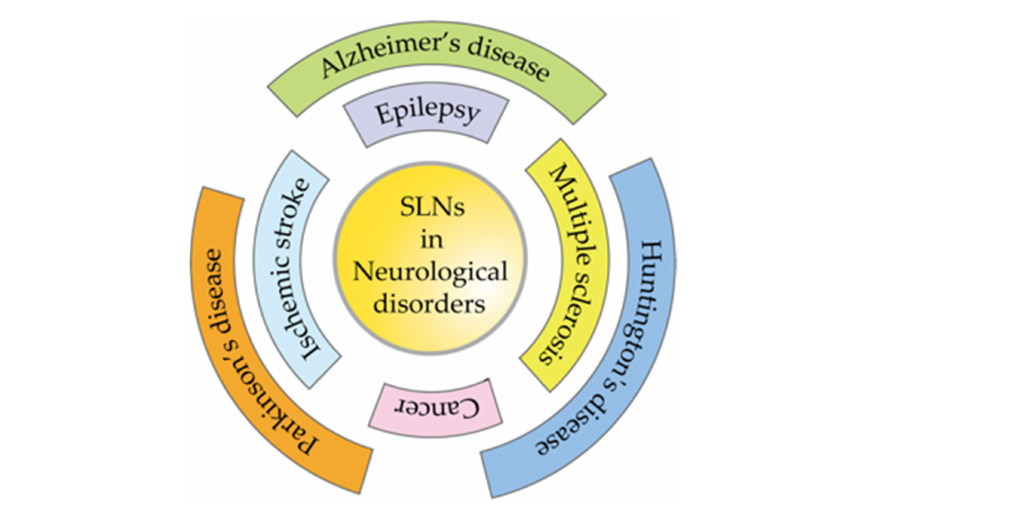
Figure 14. Representation of SLNs applications in CNS in various types of Neurodegenerative disorders. Table 4. Applications of SLNs in neurological